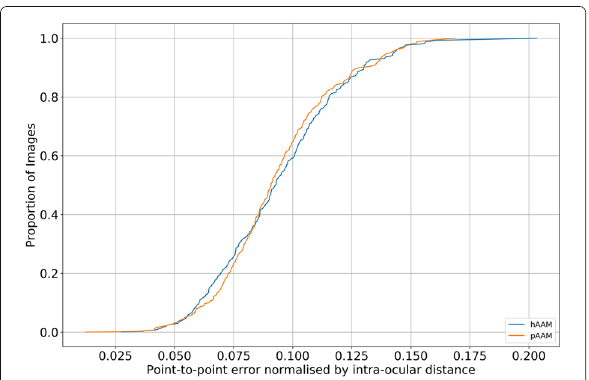
Fig. 15 HELEN cumulative error distributions. Comparing the performance of holistic AAMs and patch AAMs